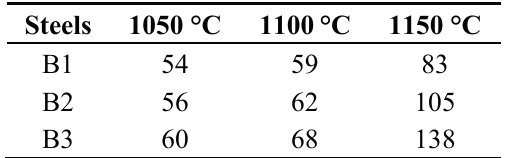
Table 1. Initial austenite grain size of the test steels ( μ